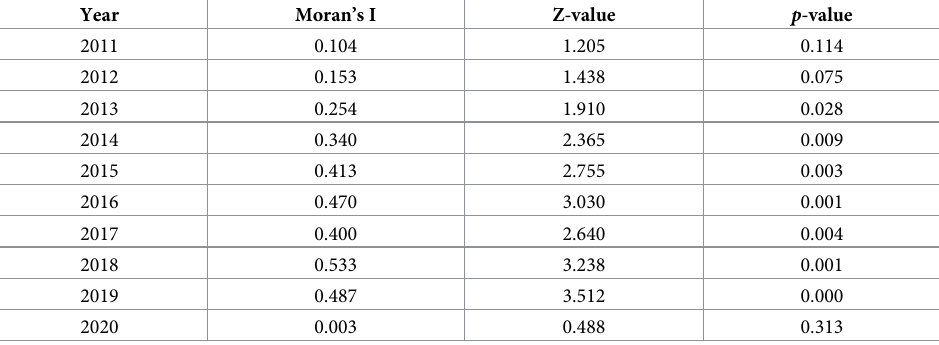
Table 4. Statistical value of Moran’s I of industrial eco-efficiency in the Yangtze River Economic